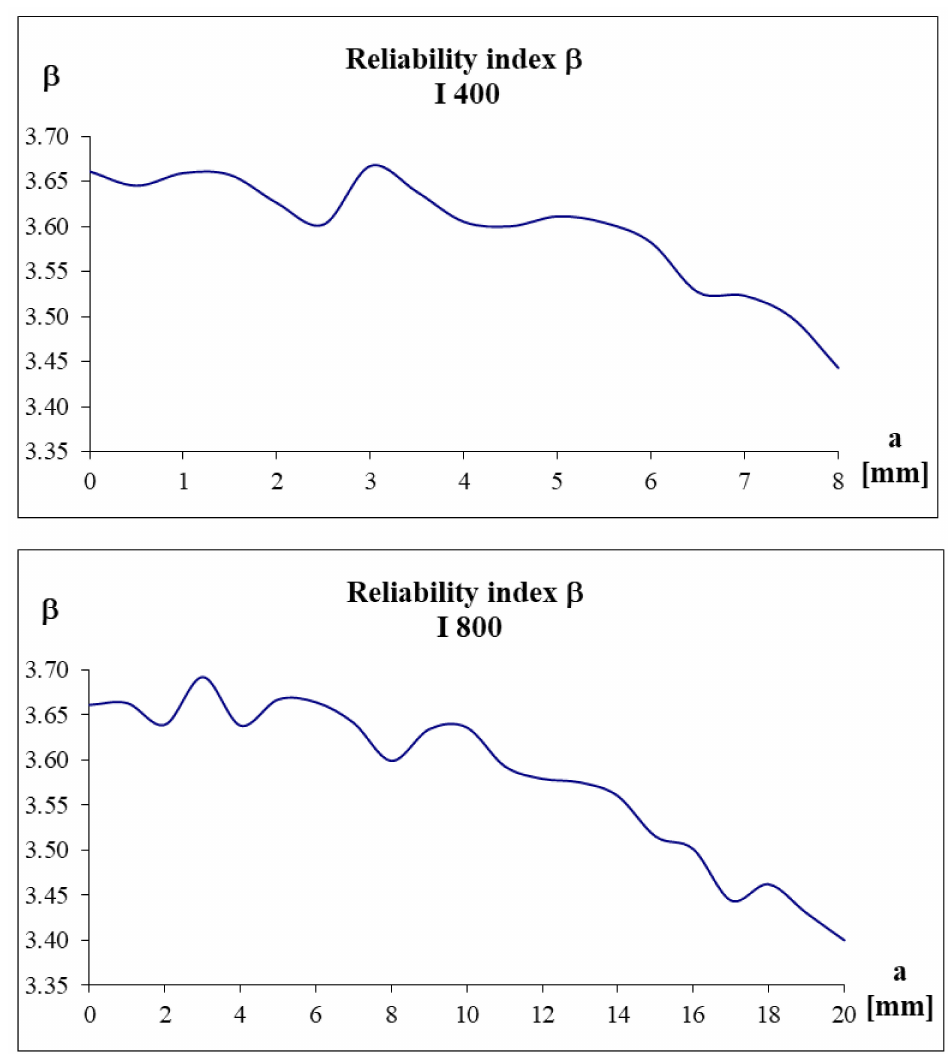
Figure 15. Dependence of reliability index β on crack depth